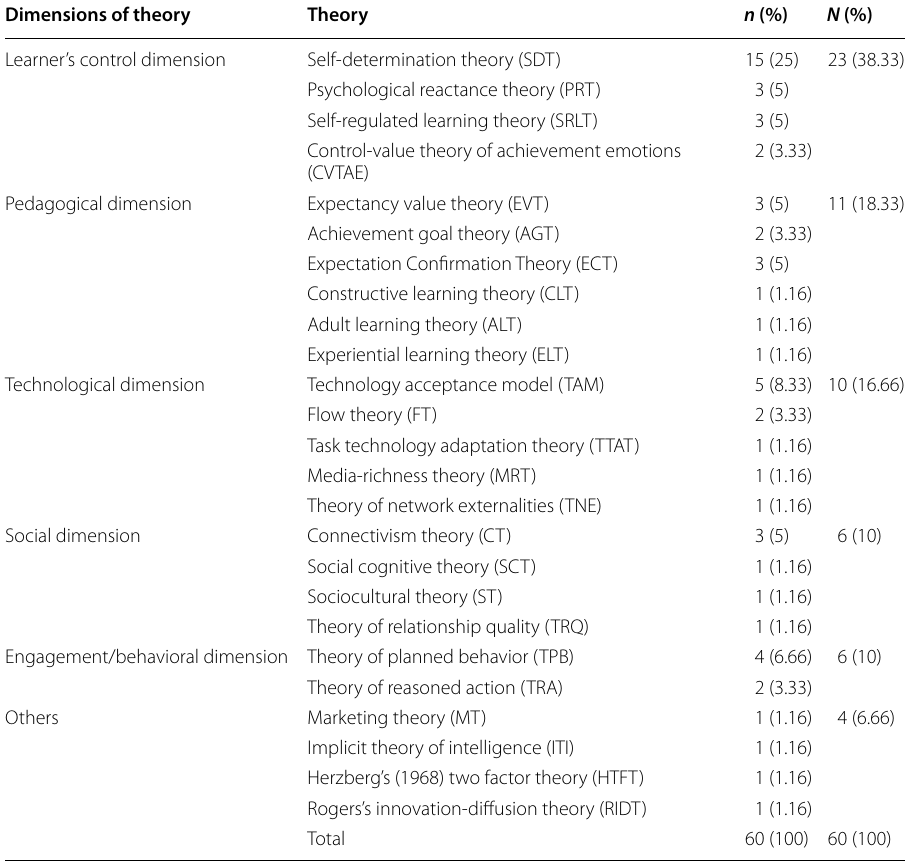
Table 3 Theories used to support participants’ motivation for MOOCs retention Dimensions of